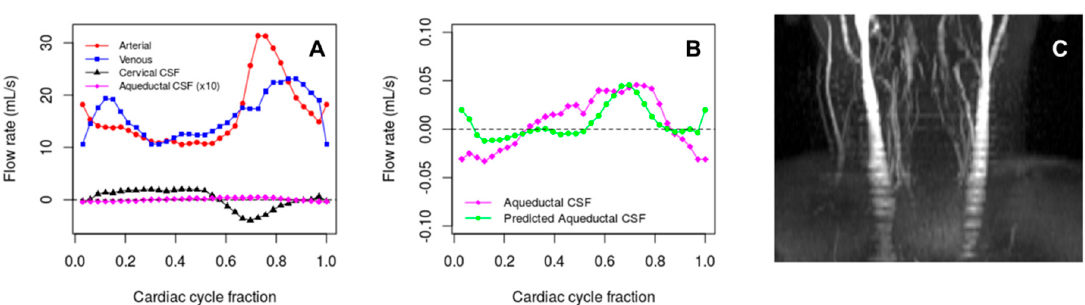
Figure 4. ( A ) Arterial, venous, cCSF and aCSF flow rates for subject 5031 (atypical), together with ( B ) actual and predicted aCSF flow rates, and ( C ) TOF MR venograph of the neck. (NB. The venous signal has been inverted in (A) for comparison purposes.) The aCSF flow was predicted from the arterial, venous and cCSF flow rates with an r 2 = 0.295).